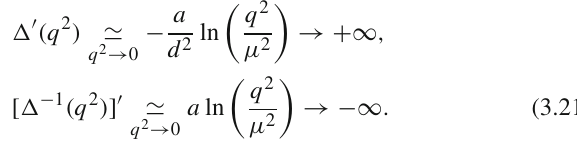
Fig. 3 The green band represents the asymptotic fits for the lattice data (gray solid circles) with q cut = 0 . 3 GeV (green dash-dotted line) and q cut = 0 . 4 GeV (green dashed curve), given by Eq. (3.12). The black continuous line corresponds to the SDE-based result, while the red dashed curve is its asymptotic limit. All asymptotic curves are given by Eq. (3.12), with the corresponding fitting parameters listed in the Table